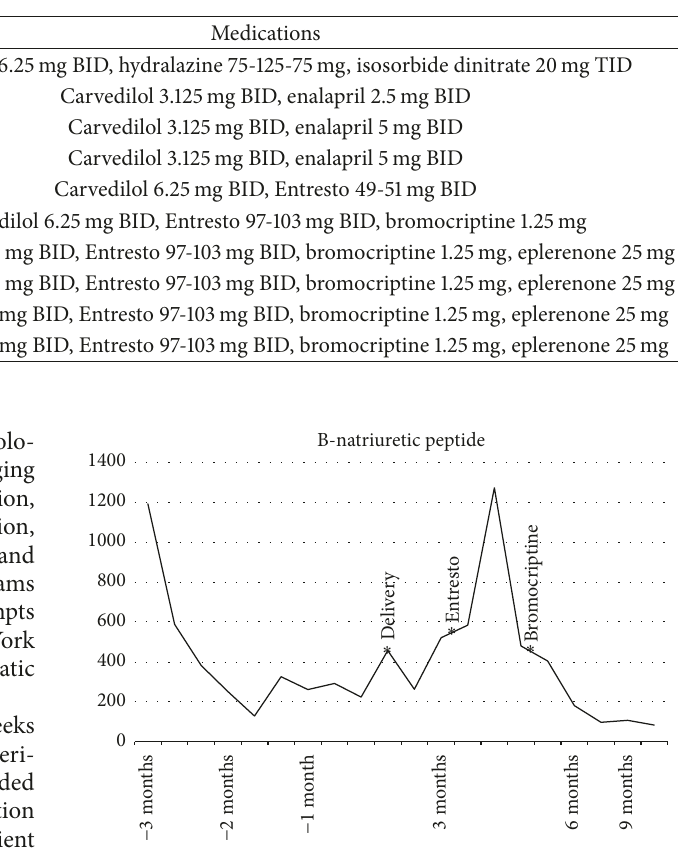
Table 1: Vital signs and medication regimen in the postpartum period.